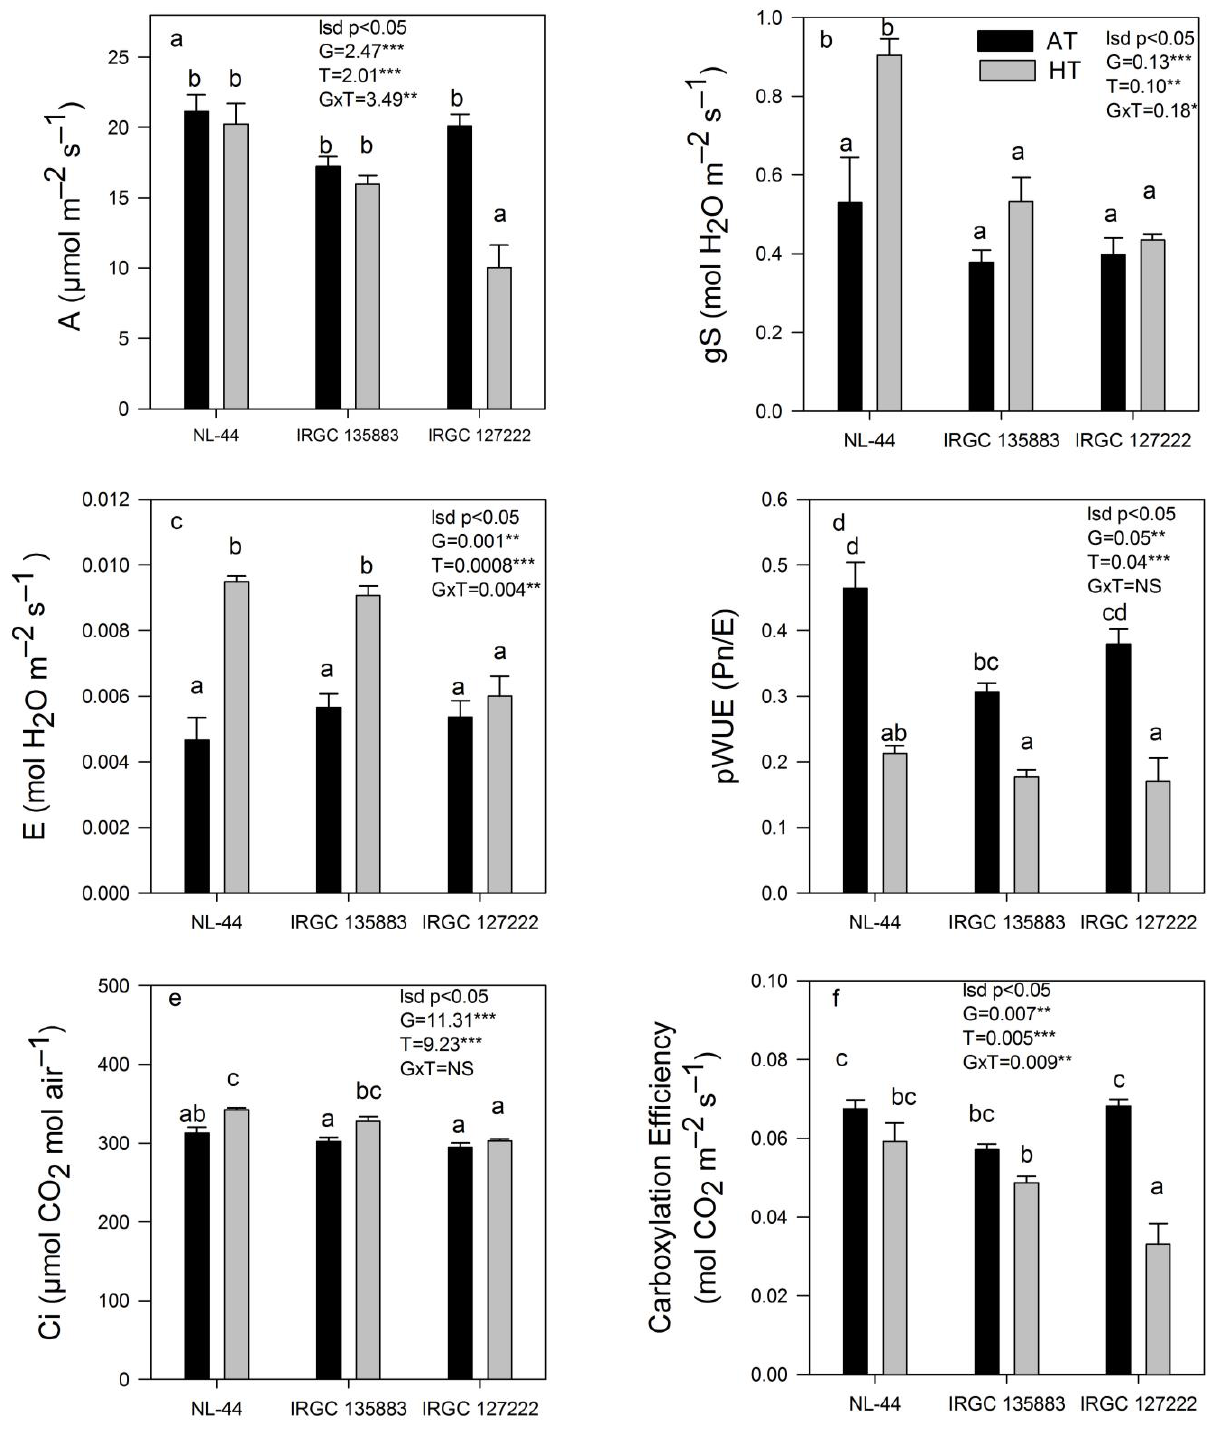
Figure 4. The effect of ambient-temperature (AT) and high-temperature (HT) exposure on ( a ) photosynthetic rate (Pn), ( b ) stomatal conductance (g s ), ( c ) transpiration rate (E), ( d ) photosynthetic water use efficiency (pWUE), ( e ) substomatal CO 2 concentration (Ci) and ( f ) carboxylation efficiency (CE) of contrasting rice accessions during the reproductive stage was measured. Means of three replicates are indicated by the vertical columns in the figure. Error bars indicate the ± SEM. The least significant difference test was used to determine significance. Means with the different letters are significantly different at level * p < 0.05, ** p < 0.01,*** p < 0.001, NS